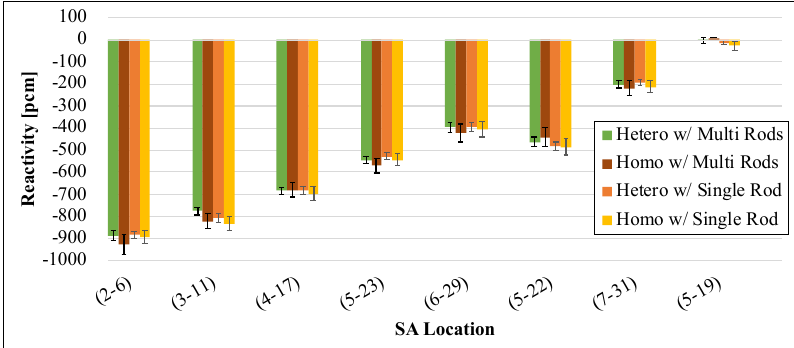
Figure 7. Swap Reactivity Results